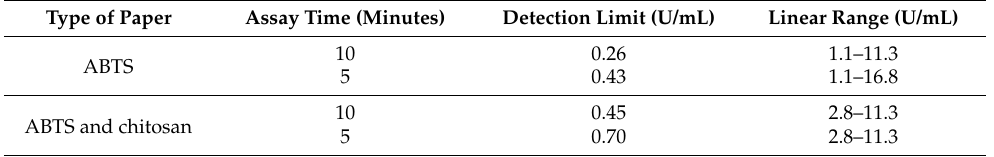
Table 1. Analytical features of the paper-assisted amperometric assays used for laccase activity evaluation. Type of